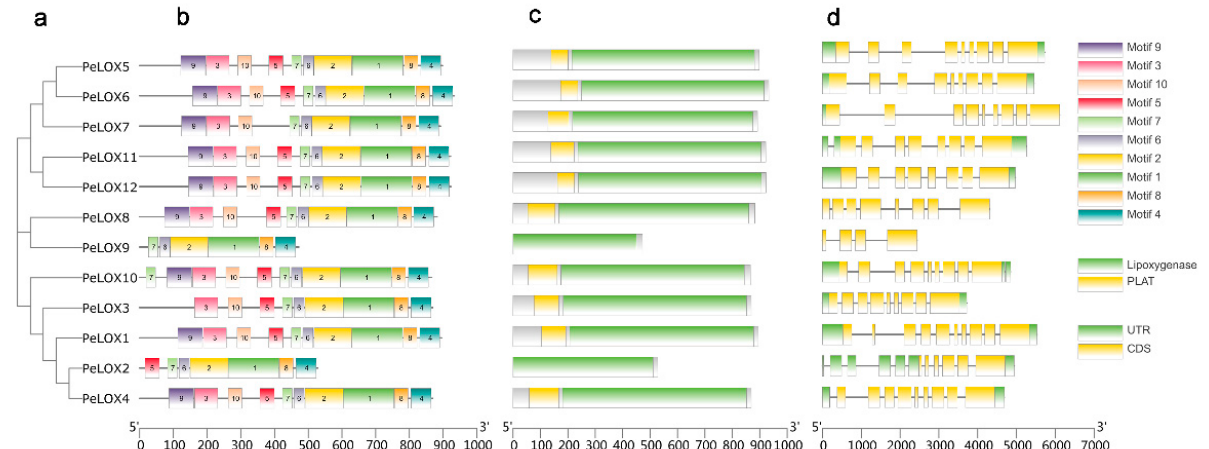
Figure 3. Phylogenetic relationships, gene architecture of conserved protein motifs and gene structure in PeLOX genes. ( a ) Phylogenetic tree based on the PeLOX genes sequence. ( b ) The motif composition of PeLOX family. Different colored boxes display different motifs. ( c ) Batch CD result of PeLOX genes, most of the members contained the conserved Lipoxygenase and PLAT domains. ( d ) The exon–intron structure of PeLOX genes.